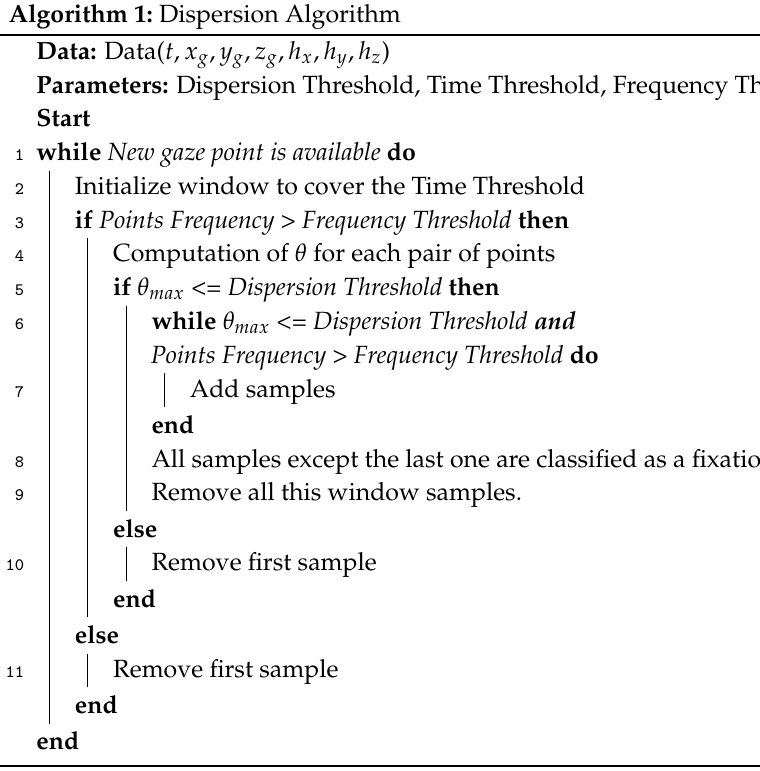
Algorithm 1: Dispersion